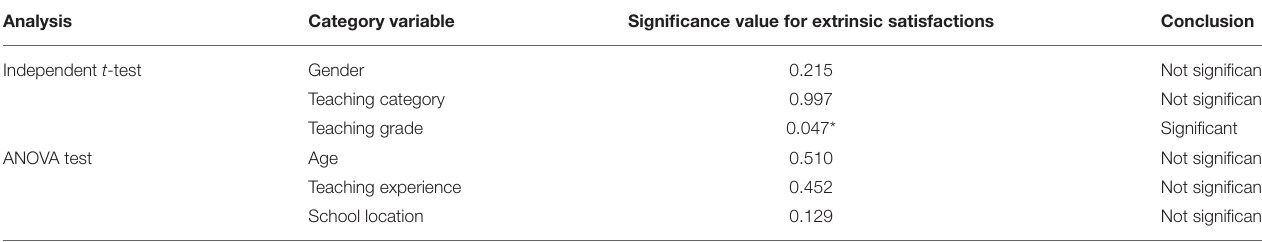
TABLE 5 | Mean difference for extrinsic satisfactions with demographic profile.